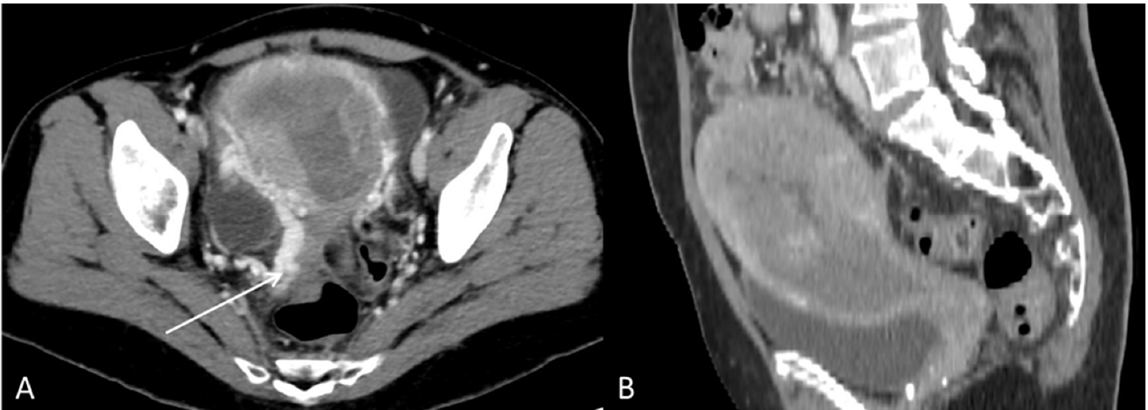
Figure 7. The CT with contrast enhancement performed after approximately two months of sorafenib treatment showed a morphological progression of the primary tumour in the uterus. During this time, the patient had also received radiation therapy (3Gyx10) of the uterus as palliative treatment due to heavy vaginal bleeding. ( A ) Axial CT and ( B ) sagittal CT showed tumour masses in the uterine cavity with patchy hypodensities consistent with necrosis. In the tumour periphery, contrast-enhanced varicose veins were visible, consistent with pelvic congestion syndrome ( A , arrow).